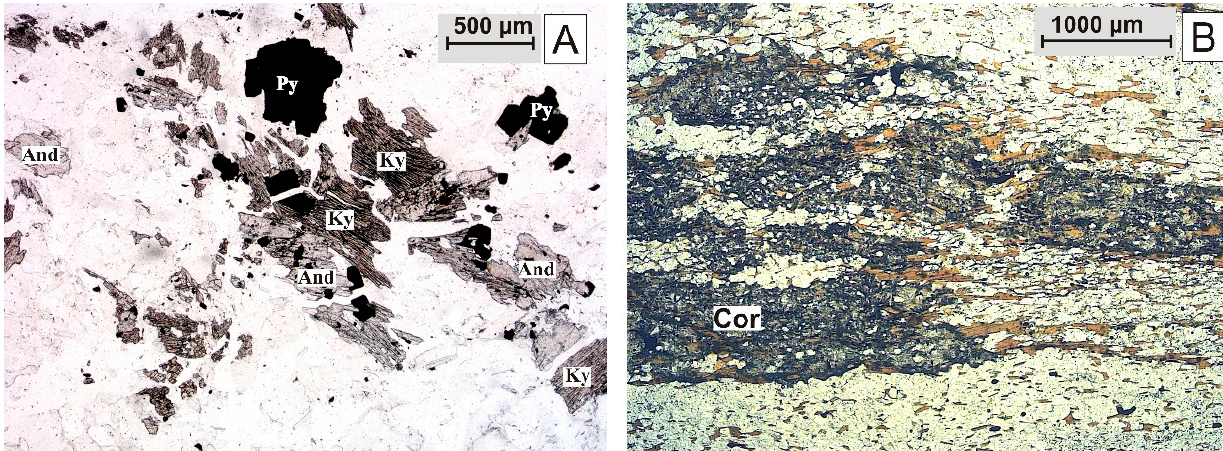
Figure 2. Paramorphoses of kyanite after andalusite in quartz–muscovite–kyanite schist ( A ) and decomposition of cordierite in biotite–cordierite plagioschist ( B ) as a result of the Early Proterozoic metamorphism. Thin section photo, plane polarized light. And—andalusite; Cor—cordierite; Ky—kyinite; Py—pyrite.